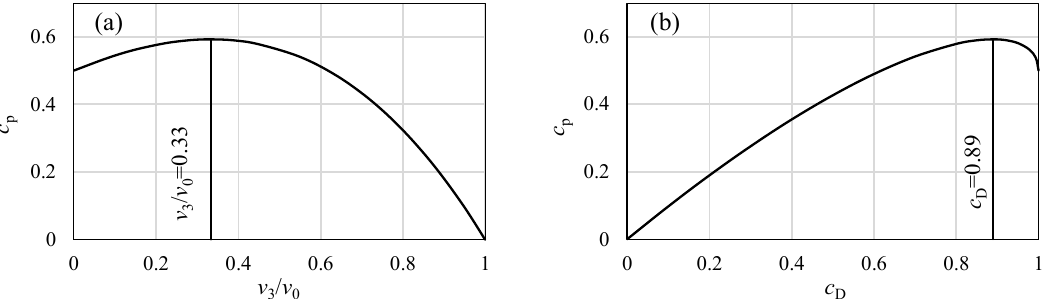
Figure 4. Betz’s law, plotted in two different forms: ( a ) power coefficient against the velocity ratio v 3 / v 0 ; ( b ) power coefficient against the thrust coefficient c D